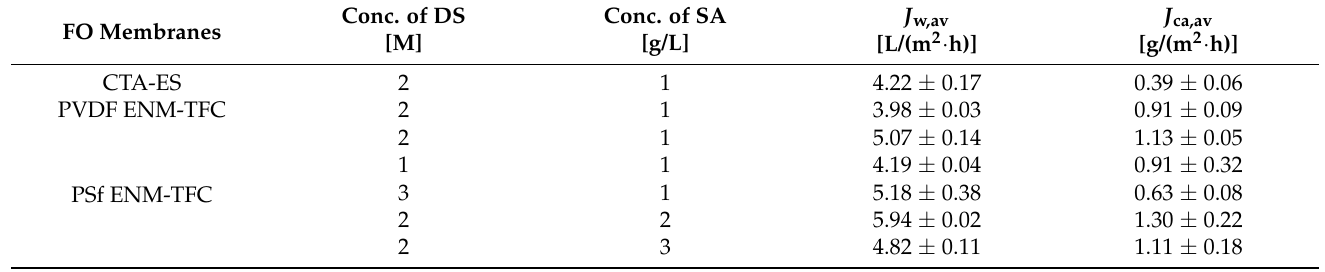
Table 2. Average water flux, J w,av , and reverse solute flux (RSF), J ca,av , of Ca 2+ in forward osmosis (FO) recovery of Ca-Alg after 4 h of FO with various FO membranes. Here, a 1–3 M CaCl 2 draw